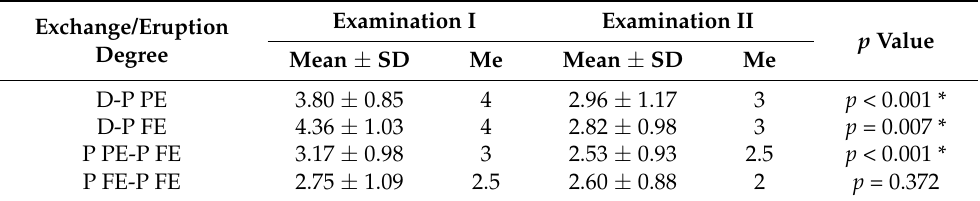
Table 3. The width of attached gingiva changes including a type of tooth exchange and degree of eruption.